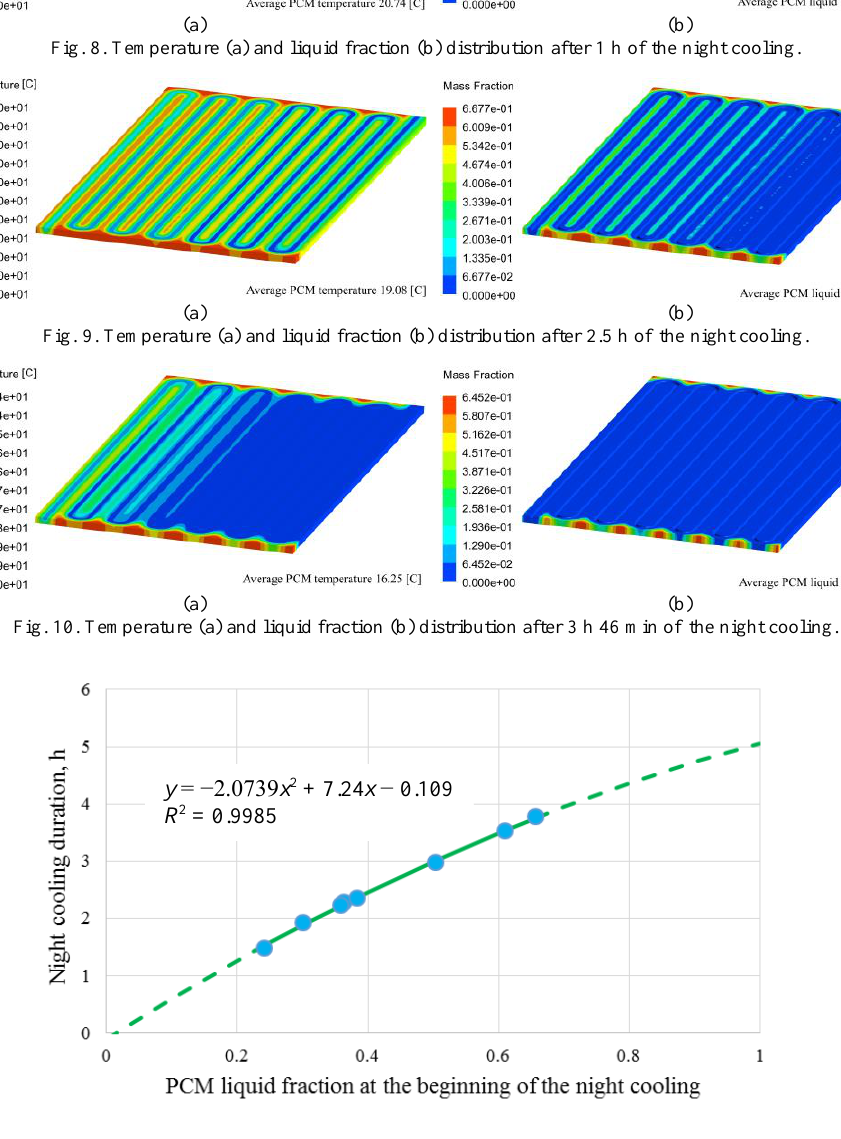
Fig. 11. Night cooling duration dependency on the initial PCM liquid fraction.